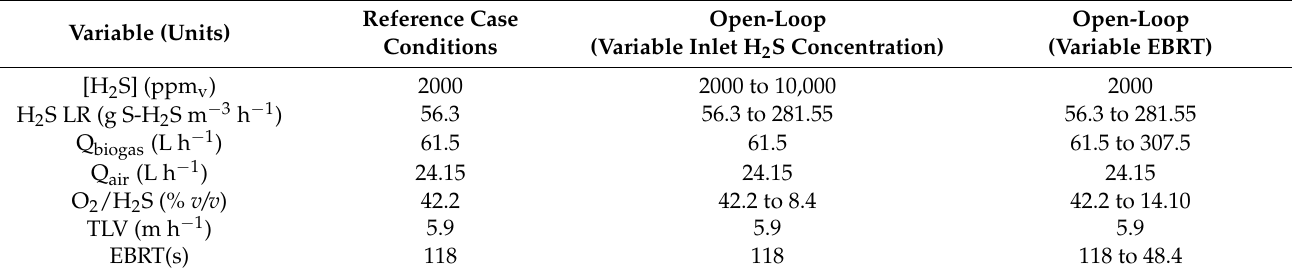
Table 2. Reference conditions for Open-Loop